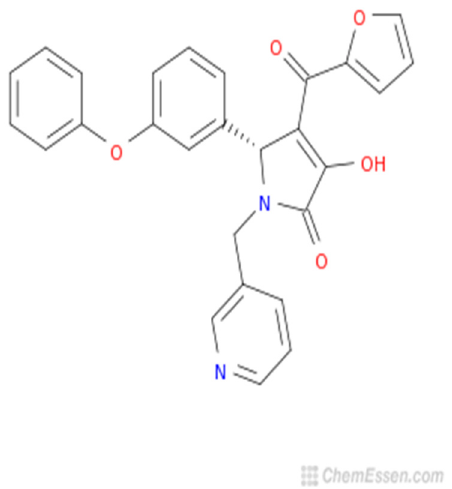
Figure 3. Zinc structure.